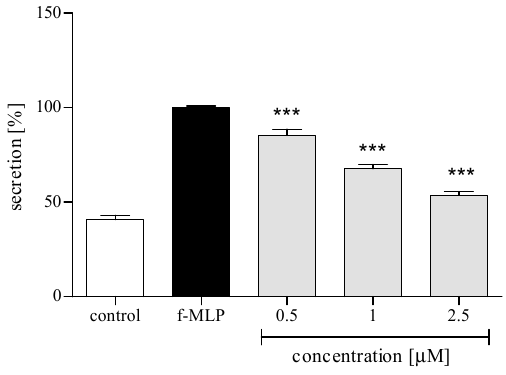
Figure 4. Inhibitory effects of trans -12-OPDA, at concentrations of 0.5, 1.0, and 2.5 μ M, on reactive oxygen species (ROS) release from f-MLP-stimulated human neutrophils. Statistical significance *** p < 0.001, with reference to a stimulated control.